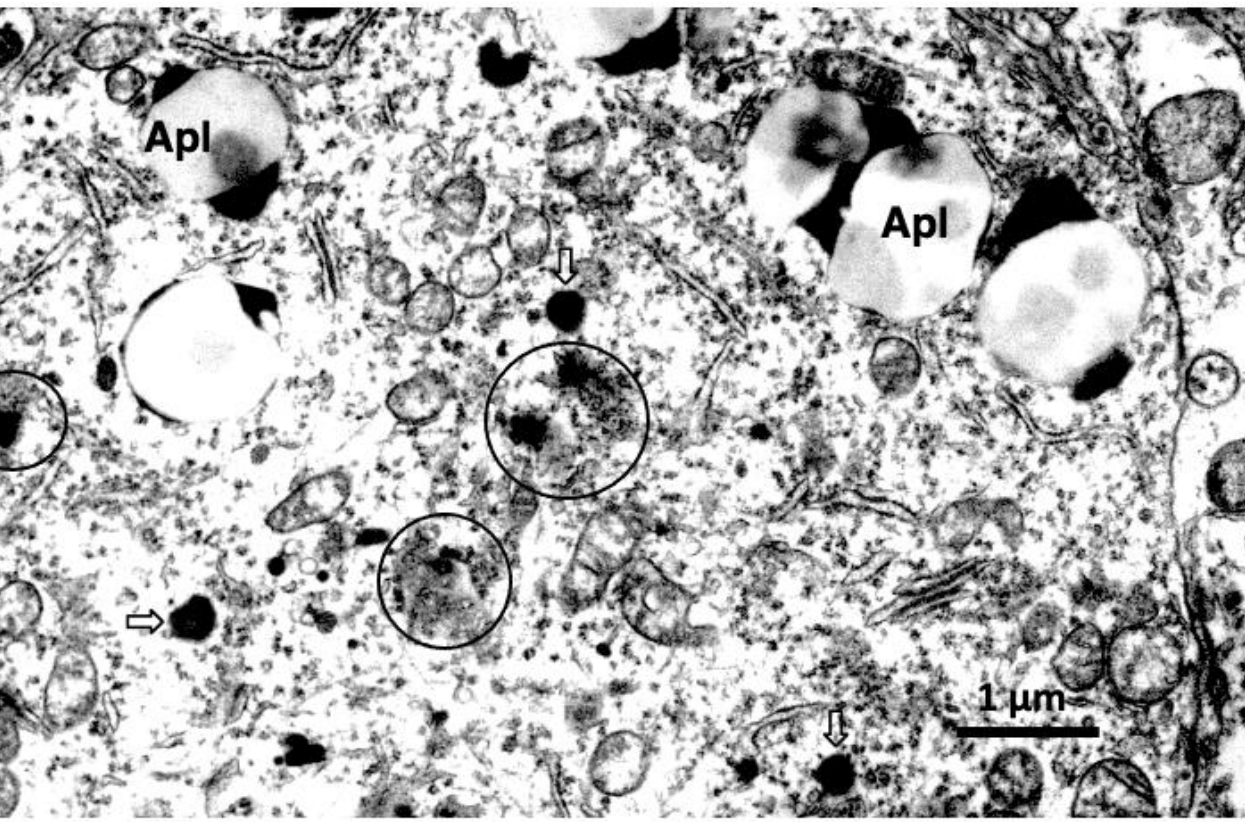
Figure 7. Electron microphotograph of the cortical neuron of a patient with Alzheimer’s disease. The Alzheimer neuron shows blurring of the limiting membrane of lysosomes with leakage of fine- granular contents and amorphous substance (circles). Ruptured lysosomes (circles) show a marked contrast with normal lysosomes (open arrows). Both increase of giant autophagolysosomes (Apl) and decrease of vivid lysosomes indicate long-standing degeneration in the Alzheimer neurons. (By the courtesy of Prof. Ralph A. Nixon, Nathan S. Kline Institute and New York University Langone Medical Center, New York).